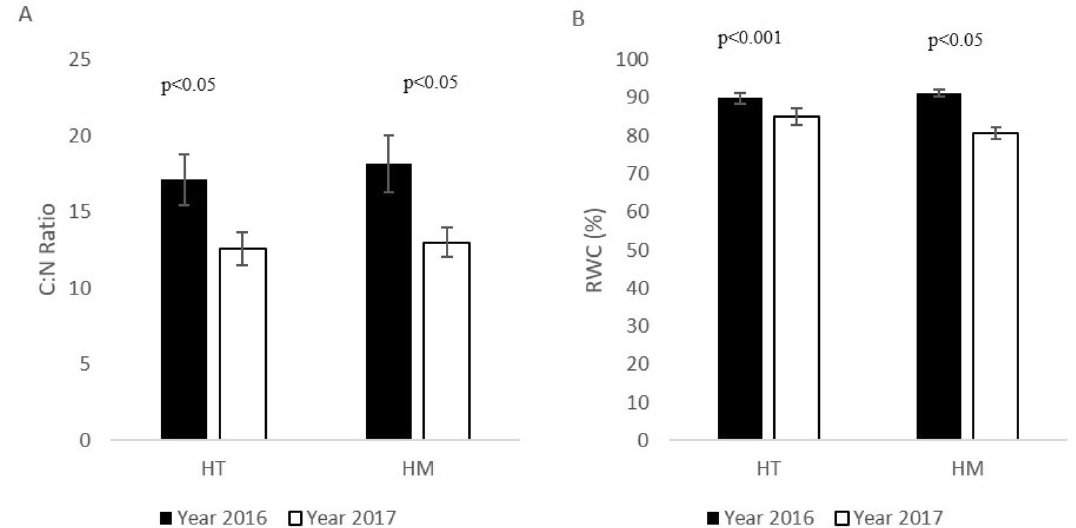
Figure 4. Mean C:N ratio ( A ) and Relative Water Content (RWC: B ) in N. mucronata leaves at the heterogeneous and homogeneous hillslopes, for 2016 and